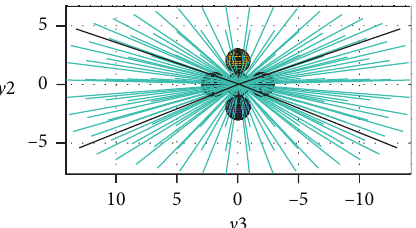
Figure 10: Front projection of the 3D lidar’s view for three ob- stacles in 5m.